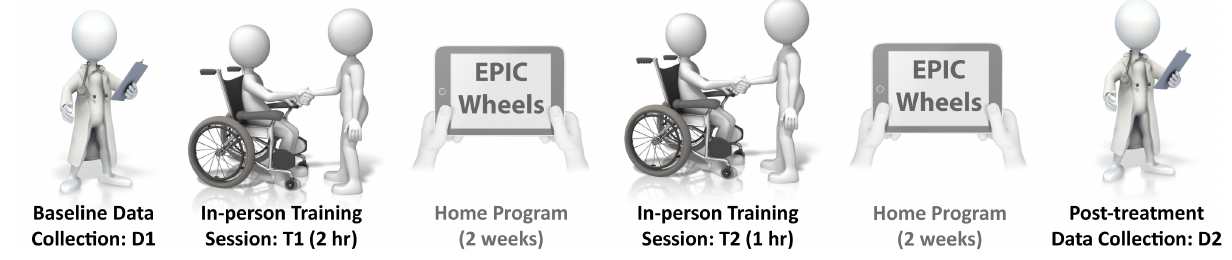
Figure 1. Study components and